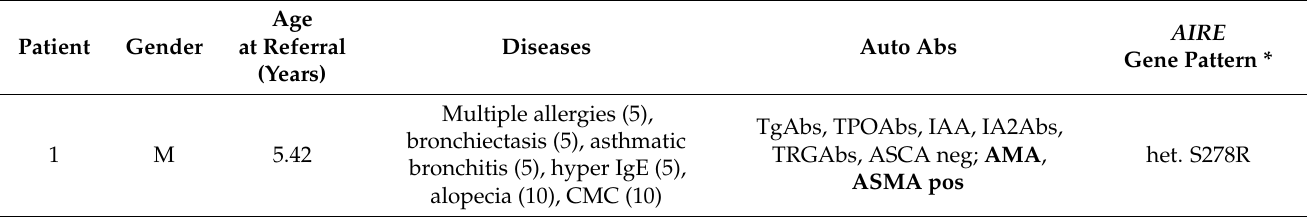
Table 1. Clinical and immunological characteristics of APECED-like